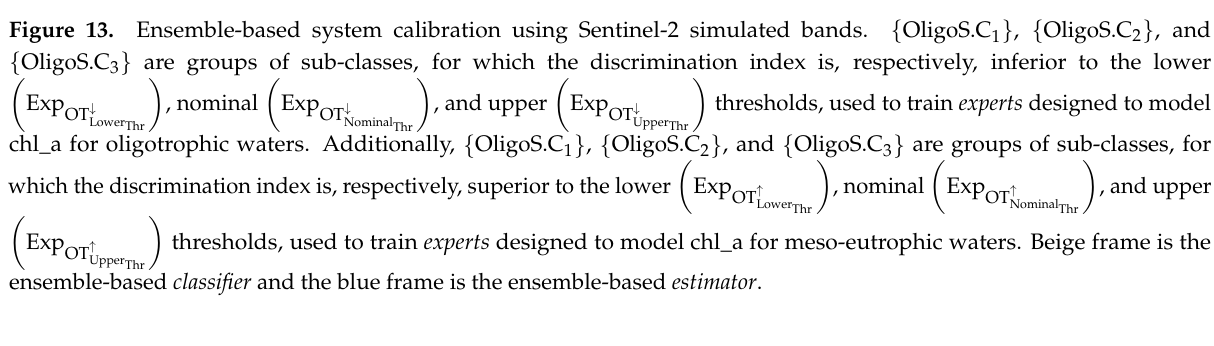
} , { OligoS.C } , and 2 1